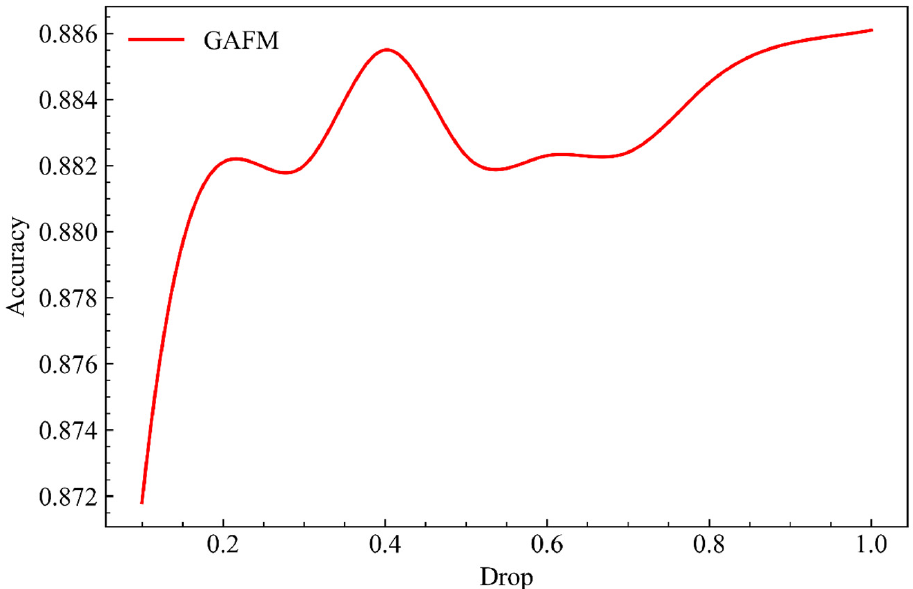
Figure 8. Prediction accuracy of GAFM under drop.